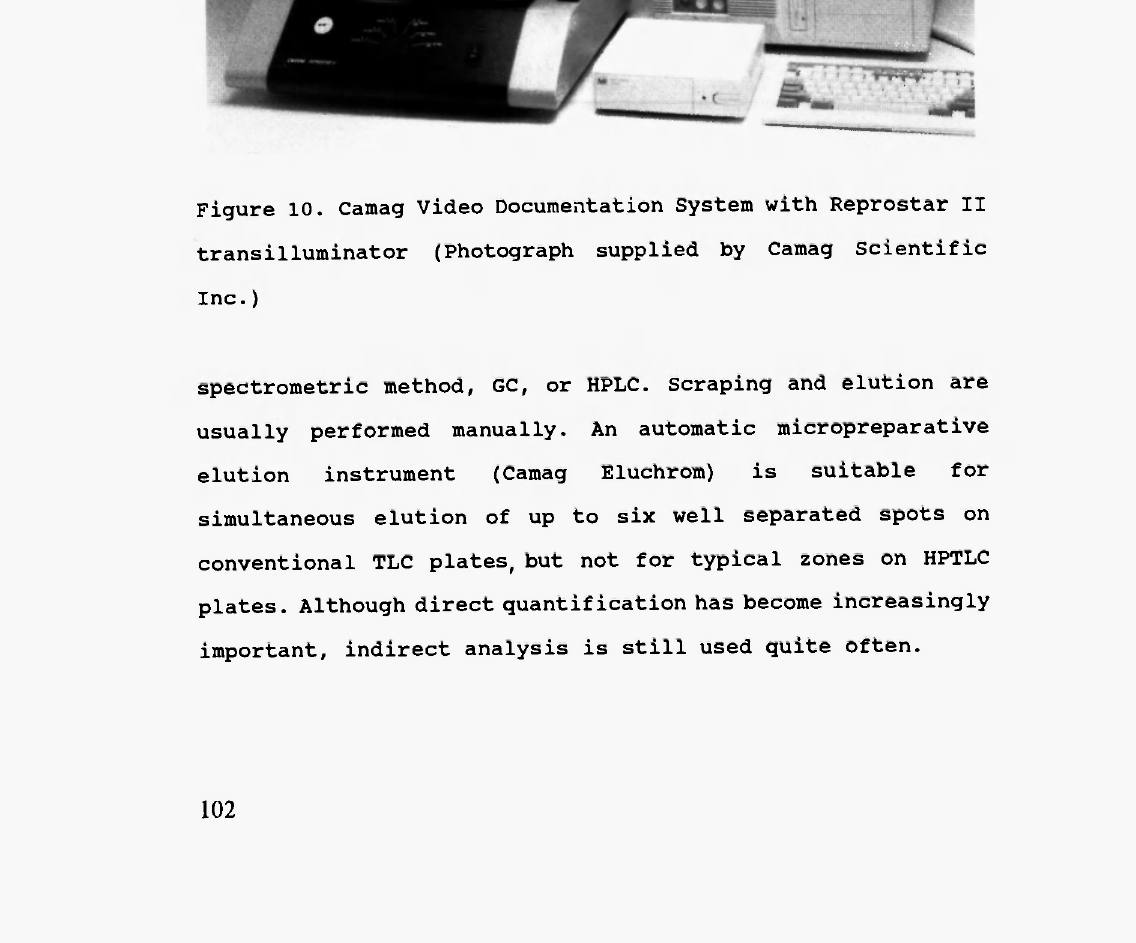
Figure 10. Camag Video Documentation System with Reprostar II